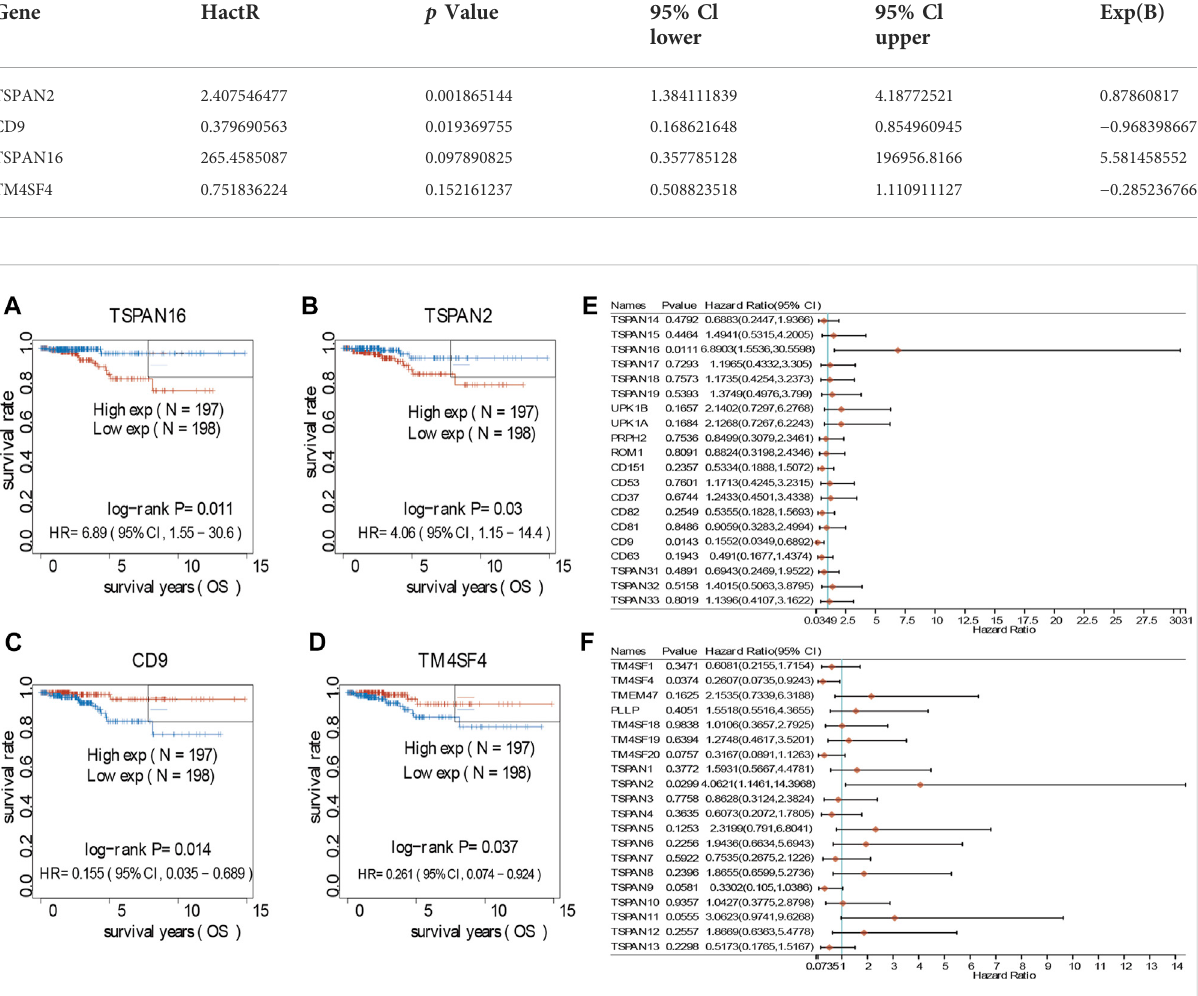
FIGURE 7 Survival analyses of TM4SFs in PTC patients. (A – D) Survival analyses curves of TM4SF family members with statistical signi fi cance in PTC ( p < 0.05); (E,F) Forest plot of survival analysis of TM4SFs for PTC